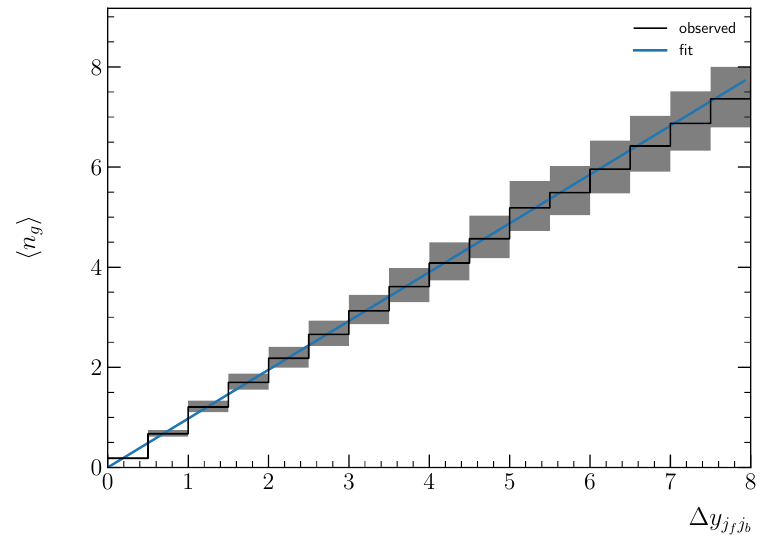
Figure 2. Average number of additional gluon emissions n g as a function of the rapidity span between the extremal jets. The bin entries show the observed numbers in the production of a Higgs boson in association with at least two jets. The solid line shows the function used for the phase space